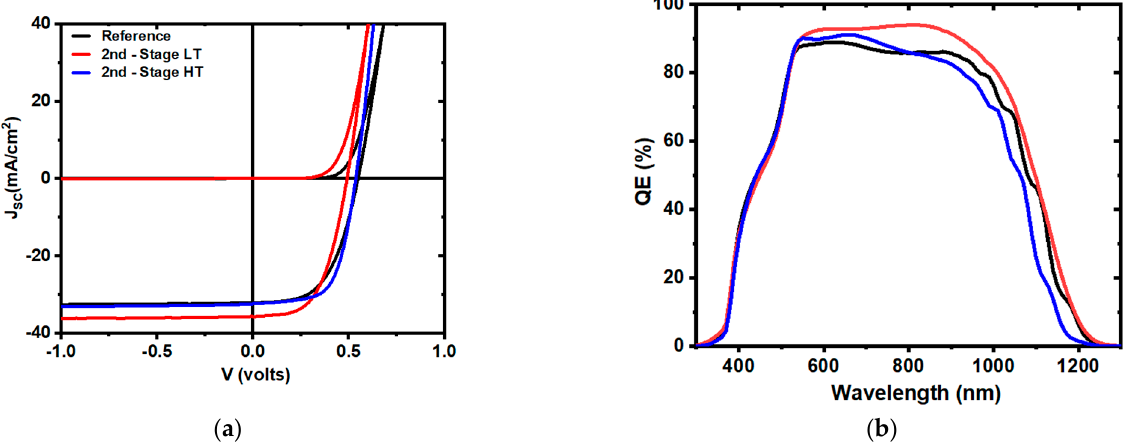
Figure 4. Representative J-V ( a ) and QE ( b ) curves for reference (black), second stage LT (red) and second stage HT (blue) devices. Table 3. Photovoltaic characteristics and diode parameters of the representative cells shown in Figure 4. Sample